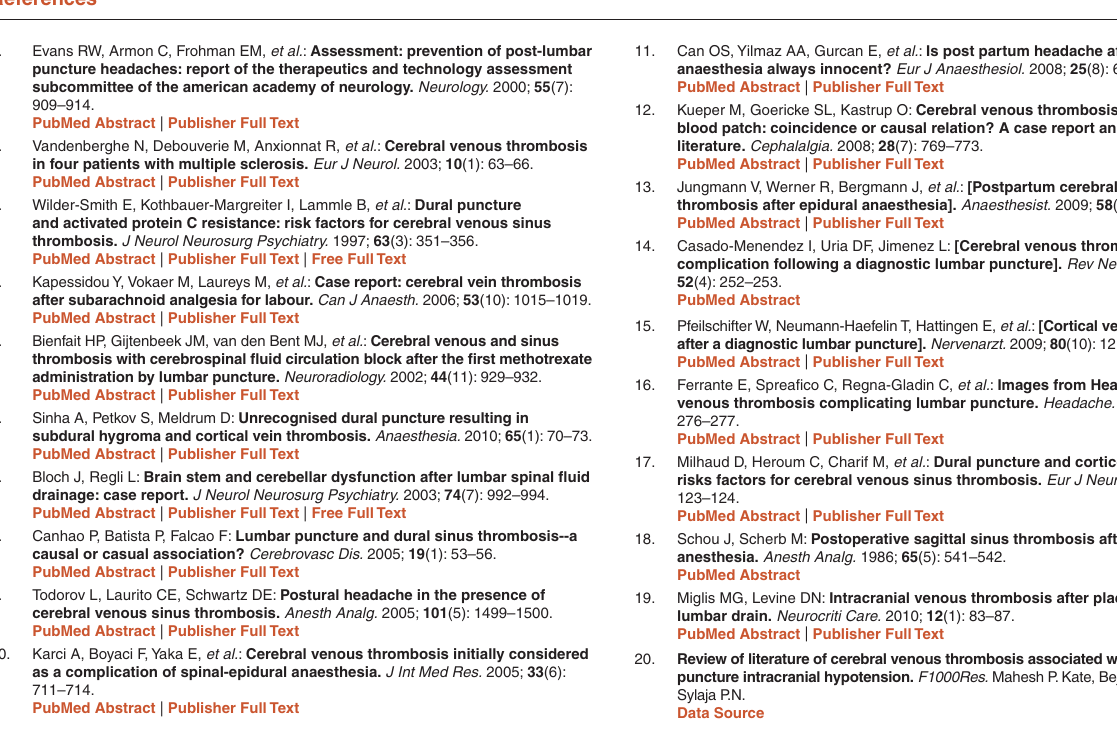
Figshare: Review of literature of cerebral venous thrombosis asso- ciated with post-lumbar puncture intracranial hypotension, http:// dx.doi.org/10.6084/m9.figshare.920192